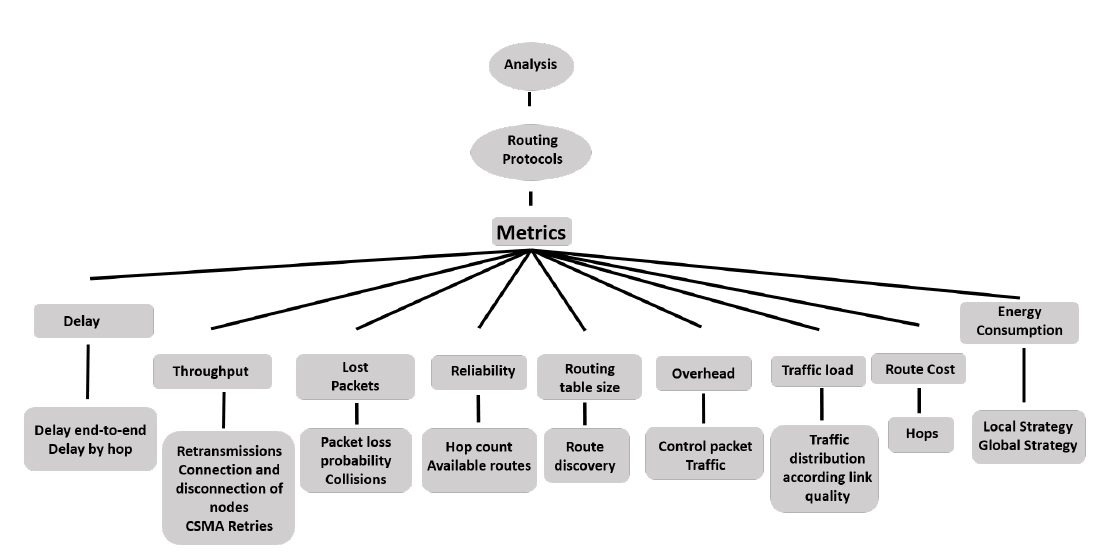
Figure 2. General performance